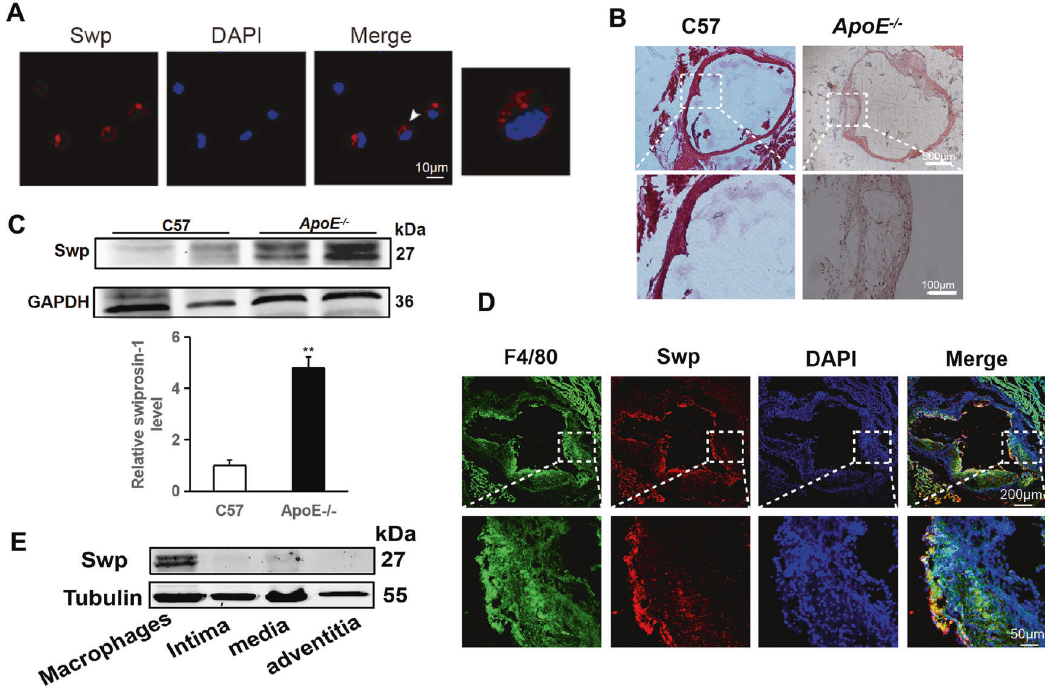
Fig. 1 Swiprosin-1 expressed in macrophages of mouse atherosclerosis plague. A Representative image of immuno fl uorescent staining for swiprosin-1 (red) in RAW264.7 macrophages. The localization of the nucleus was detected by DAPI staining (blue). Scale bars are 10 μ m (left) and 2 μ m (right). B Representative images of aortic root sections stained with hematoxylin and eosin. n = 3/group. Scale bars are 500 μ m (upper) and 100 μ m (down). C Representative Western blot for swiprosin-1 expression in aorta tissue from C57BL/6 and ApoE − / − mice fed a high-cholesterol diet for 4 months (upper) and densitometric analysis (down). The experiment was repeated at least three times. GAPDH served as the loading control. Data are presented as the mean ± SE; ** P < 0.01. D Representative images of immuno fl uorescent double staining for swiprosin-1 (red) and F4/80 (macrophage marker, green) in atherosclerotic plaque. The localization of the nucleus was detected by DAPI staining (blue). n = 6/group. Scale bars are 200 μ m (upper) and 50 μ m (down). E Representative Western blot for swiprosin-1